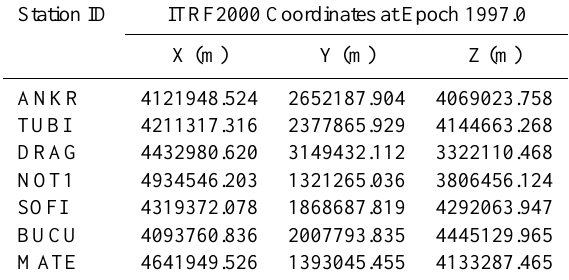
Table 3. Coordinates of IGS Stations of CORS-TR (CORS-TR Report,